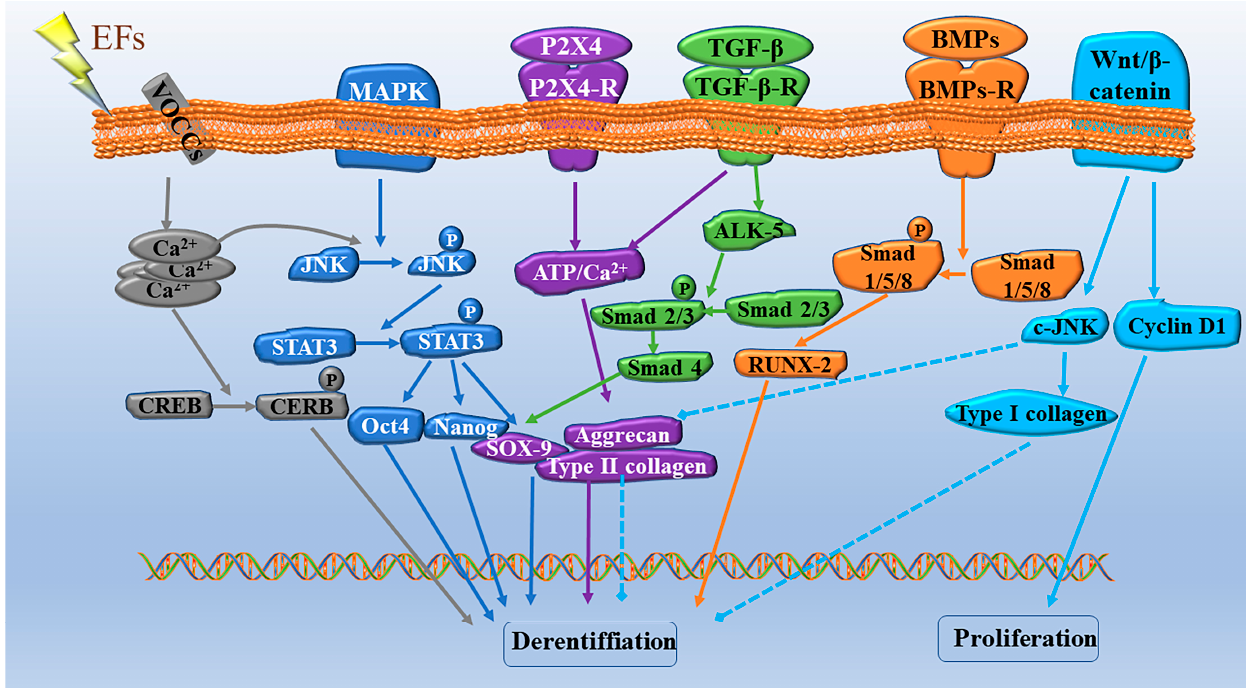
Figure 2. Signaling pathways involved in ES-induced proliferation and chondrogenic differentiation of MSCs. The EFs enhanced the Ca 2+ entering the cell via VOCC, which phosphorylates CREB and, ultimately, promotes the chondrogenic differentiation of MSCs. The EFs enhanced the chondrogenic potential of MSCs via the JNK/CREB-STAT3 signaling pathway. Under ES, P2X 4 can trigger Ca 2+ influx into MSCs in response to interactions with ATP molecules, which contribute to the chondrogenic process. ES promotes TGF- β action on TGF- β receptors located on MSCs, thereby promoting chondrogenic differentiation. Under the action of ES, BMPs can bind to BMP receptors and promote chondrogenic differentiation. ES promotes proliferation and inhibits the chondrogenic differentiation of MSCs through the Wnt/ β -catenin signaling pathway.